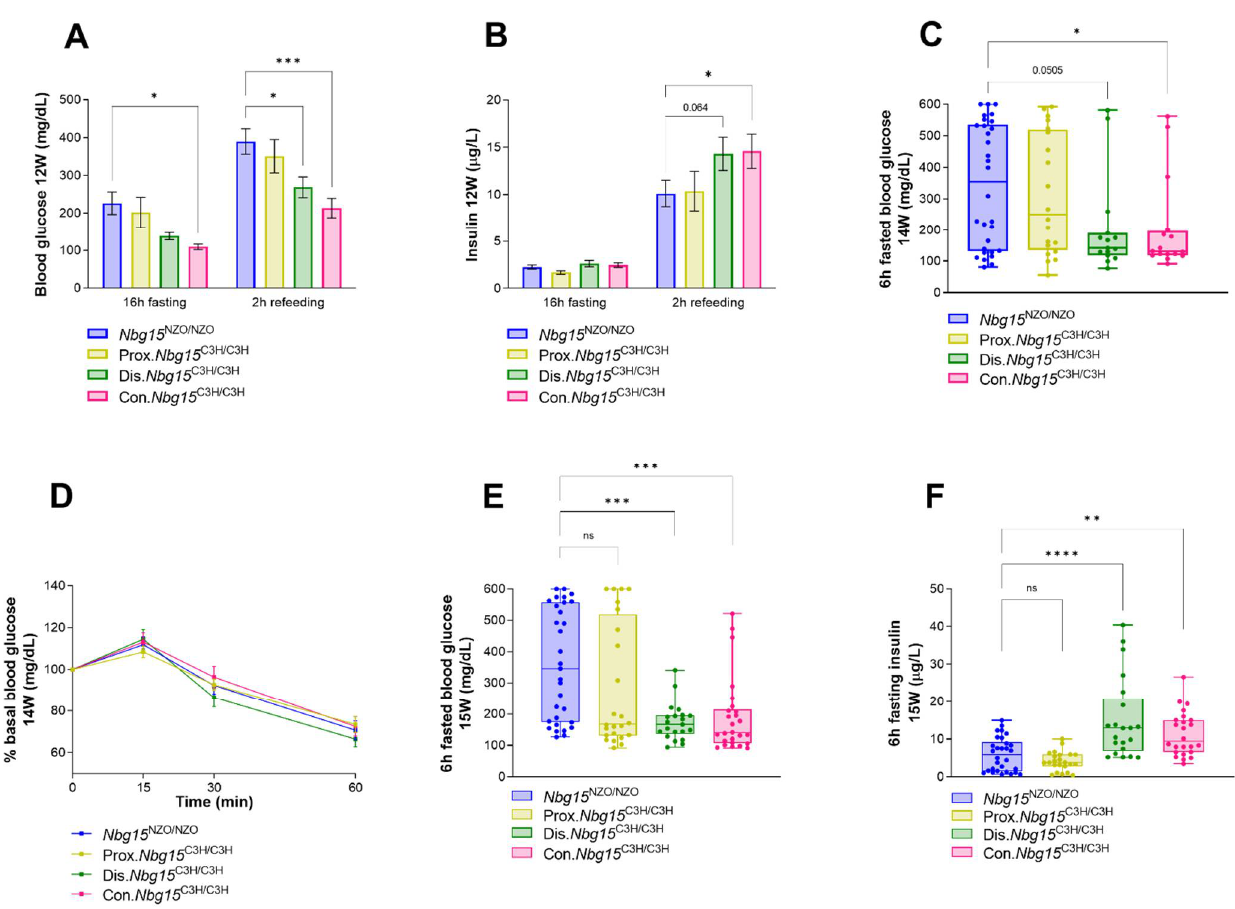
Figure 3. Nbg15dis C3H but not Nbg15prox C3H sublocus confers improvements in whole-body